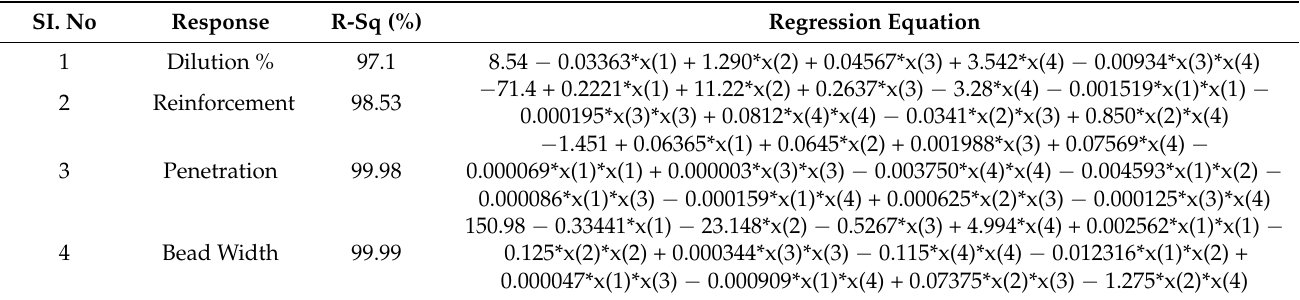
Table 7. Quadratic regression equations for responses.